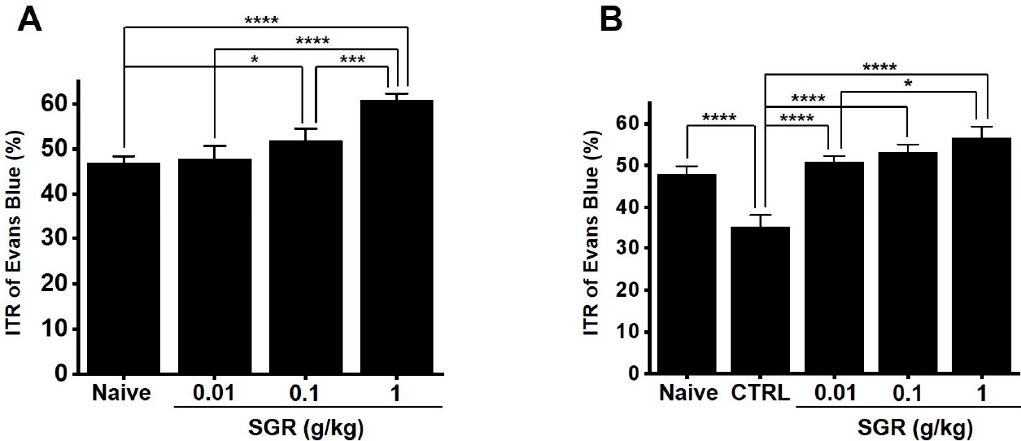
Figure 8. Effect of SGR extract on ITR in normal and AA-induced GMD mice. ( A ) In normal mice, SGR extract increased ITR. Naïve ( n = 15). SGR 0.01 g ( n = 15). SGR 0.1 g ( n = 14). SGR 1 g ( n = 15). ( B ) In this AA-induced case, the ITR was recovered by SGR extract. Naïve ( n = 15). CTRL ( n = 15). SGR 0.01 g ( n = 15). SGR 0.1 g ( n = 15). SGR 1 g ( n = 14). Bars represent mean ± standard error. * p < 0.05. *** p < 0.001. **** p < 0.0001. CTRL: Control. SGR: Smilacis Glabrae Rhixoma . ITR: intestinal transit rate. AA: acetic acid. GMD: gastrointestinal motility disorder.